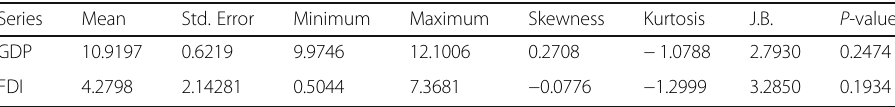
Table 1 Descriptive statistics of the data